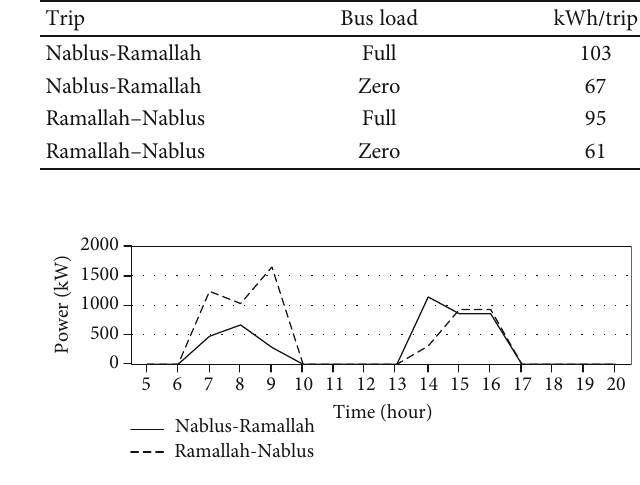
Figure 9: Daily hourly load demand of the adapted run round trip for scenarios 1 and 2.